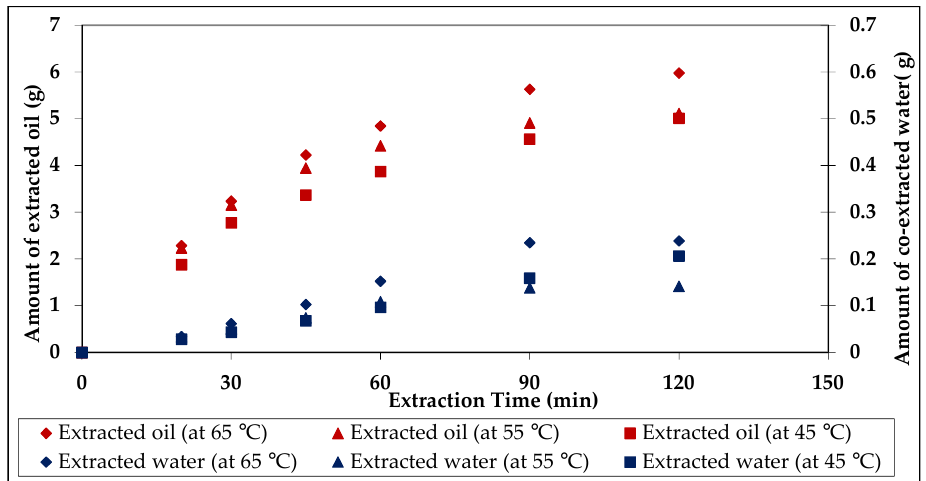
Figure 4. SCCO 2 extraction of oil and water at 400 bar, 35 kg h −1 kg −1 with 14.5 g of palm mesocarp.